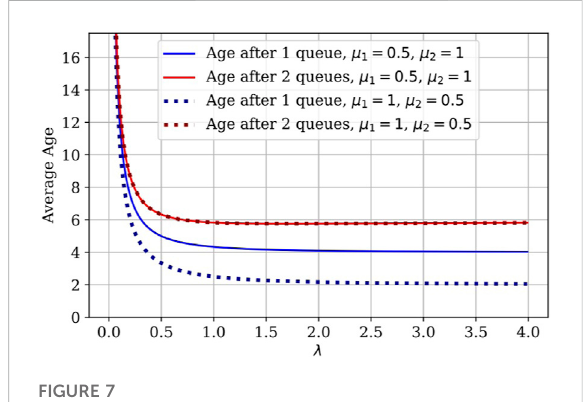
FIGURE 5 Average age vs. λ , μ = 1, queue capacity of one, preemption vs. non-preemption.